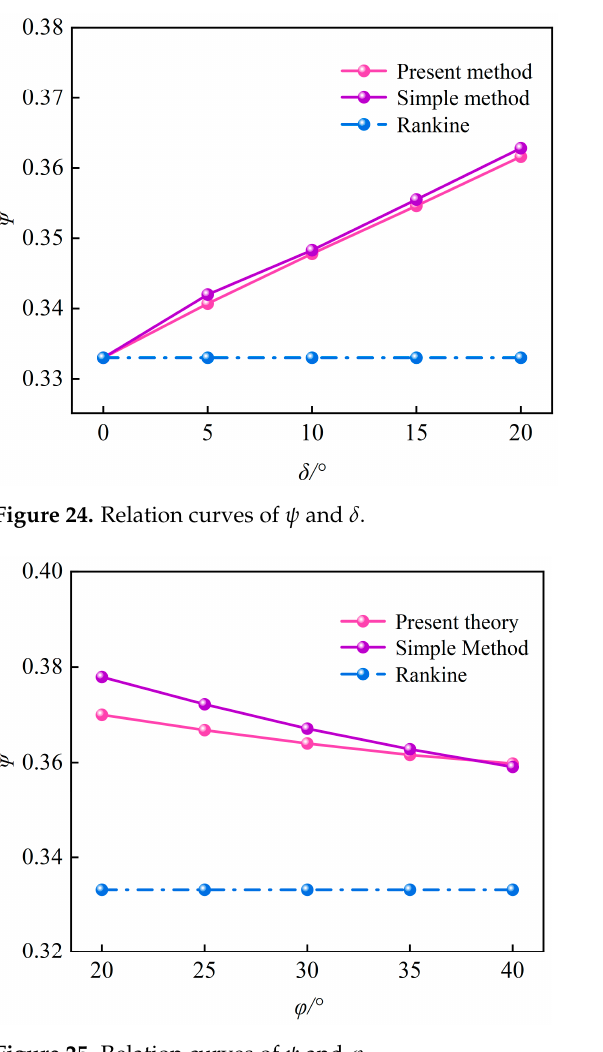
Figure 25. Relation curves of ψ and φ .